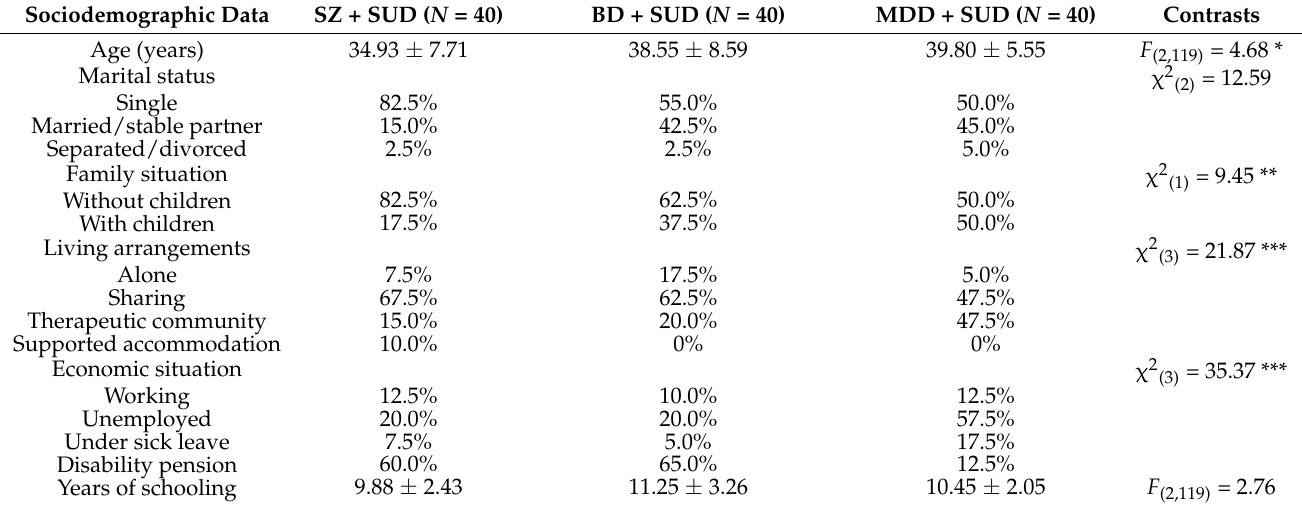
Table 1. Sociodemographic data for the three groups of patients. Means, standard deviation, percent- ages and statistical contrasts (ANOVA and chi-square